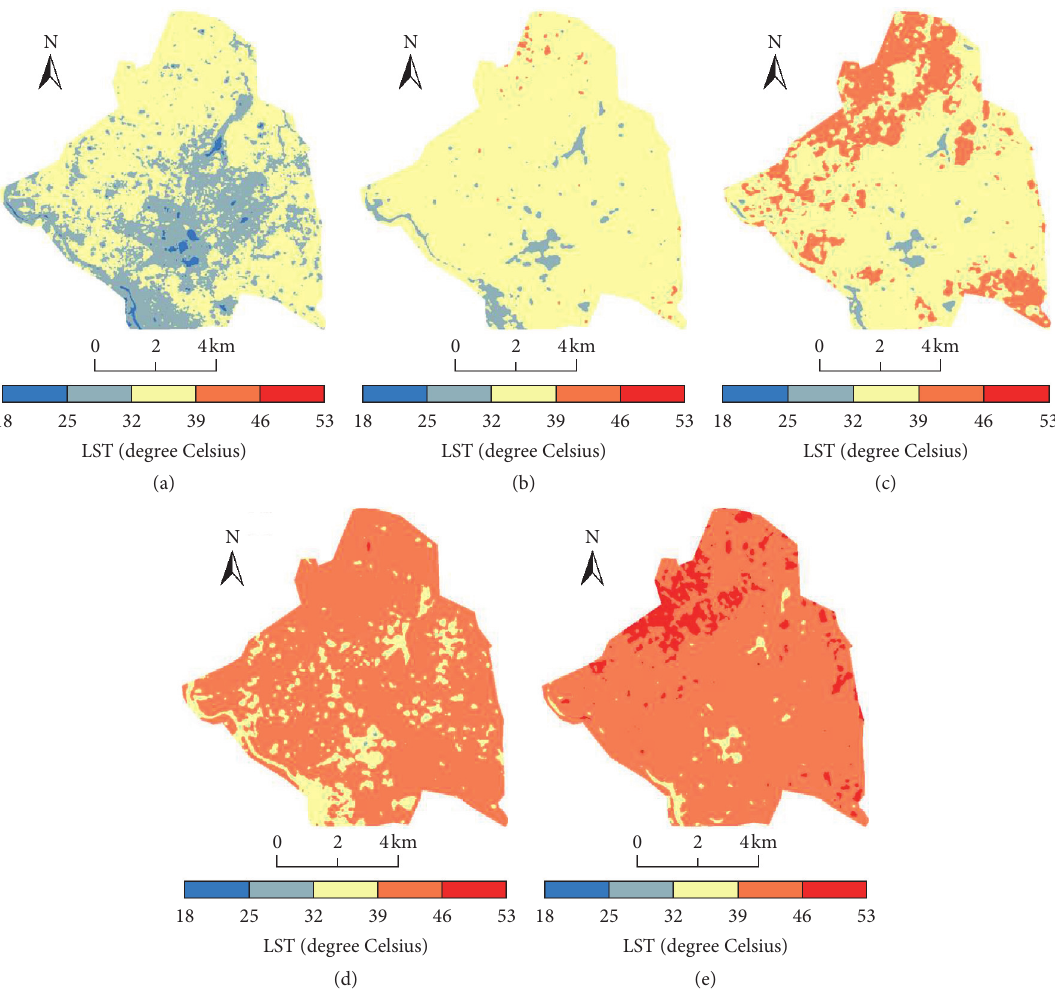
Figure 3: Distribution of mean LST ( ° C): (a) 2002 (b) 2006 (c) 2010 (d) 2014 (e)